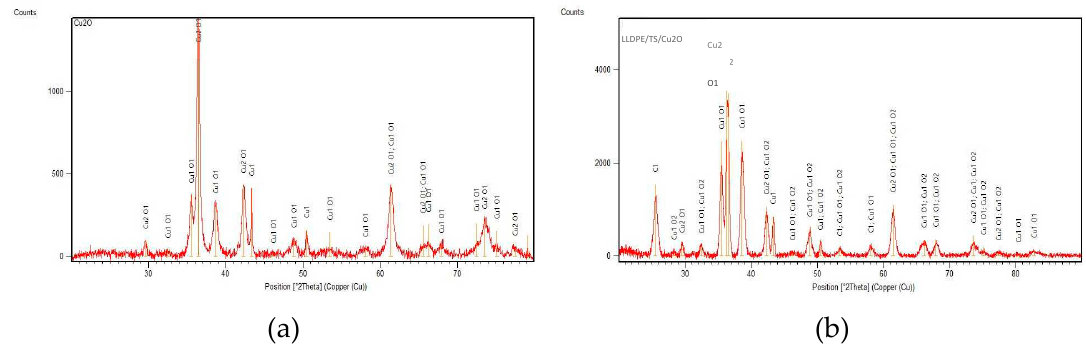
Figure 3. X-ray diffraction (XRD) analysis of ( a ) powder Cu 2 ONPs and ( b ) immobilized using trimethoxyvinylsilane Cu 2 ONPs (LLDPE/TS/Cu 2 O).